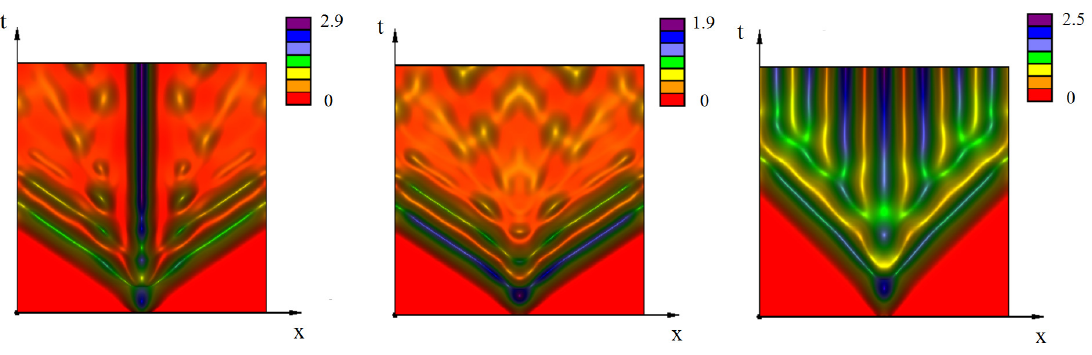
Figure 8. Numerical simulations of Equation (1). Virus evolution with time delay in the term describing the immune response represented as level lines of the solution u ( x , t ) on the ( x , t ) -plane. Different regimes coexist for the same values of parameters depending on the initial conditions, with high initial viral load ( left ) and low initial viral load ( middle ). Values of parameters: D = 10 − 4 , r = 1, q = 1, N = 0.1, f ( u ) = k 1 e − k 3 u , k 1 = 8, k 3 = 3, t = 80 ( left and middle ), k 3 = 6, t = 50 ( right ); the maximum of the initial condition 0.9 ( left ), 0.1 ( middle and right ).